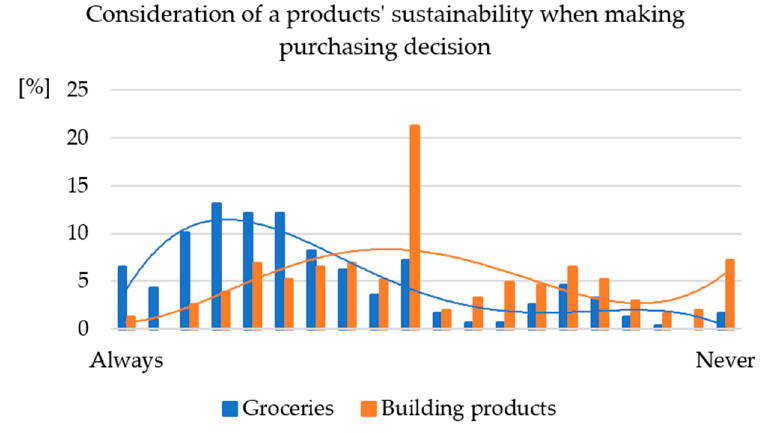
Figure 3. Consideration of a product’s sustainability when making purchasing decision.